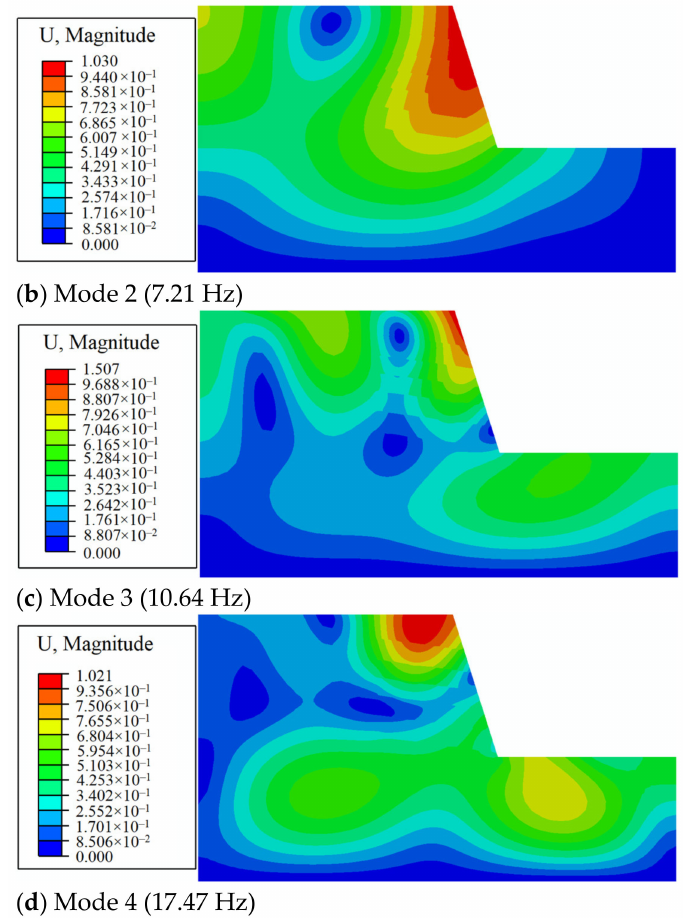
Figure 12. Results of modal analysis of the bedded rock